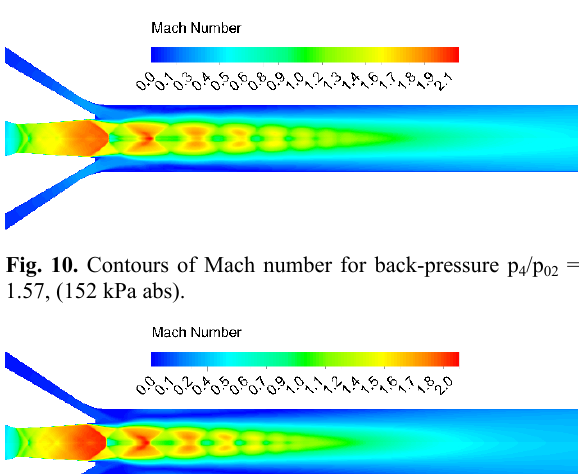
Fig. 9. Approximate illustration of the state of the refrigerant before the shock wave in pressure – enthalpy diagram.